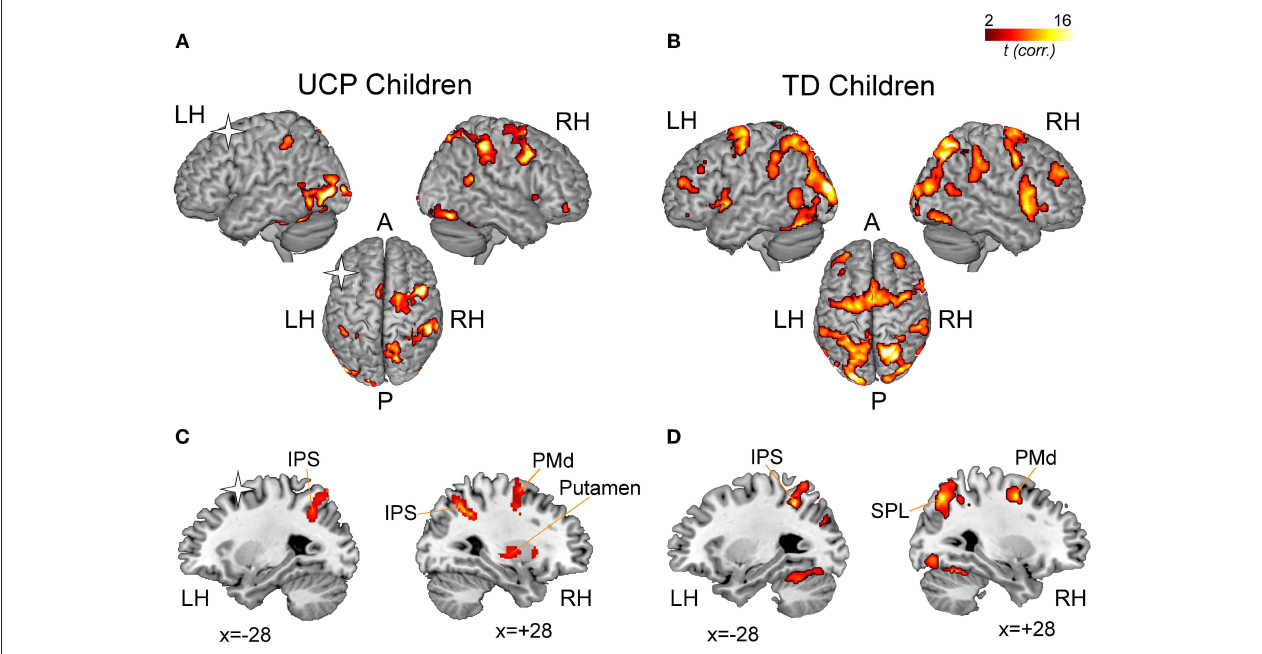
FIGURE 4 | fMRI results. Statistical maps illustrating significant activations during the imagination of grasping actions in children with UCP (A) and in TD children (B) . The statistical maps are overlaid into a standard MNI template (ch2Better, MRICron). The results of the regression analysis conducted on UCP group (C) and TD group (D) indicate correlations between percent signal change in each voxel and the individual Motor Imagery Ability (MIA) score obtained during the fMRI task using the non-preferred hand. A, Anterior; LH, Left Hemisphere; P, Posterior; RH, Right Hemisphere. Asterisks indicate the lesioned hemisphere in UCP patients.